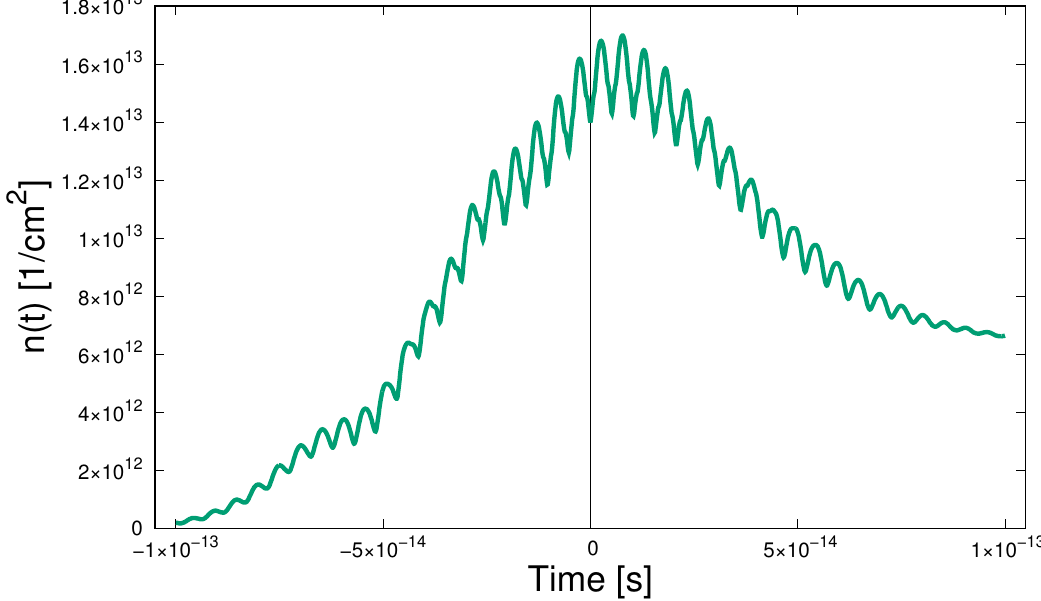
Figure 10. Time dependence of the carrier density for the infrared pulse of Figure 8.